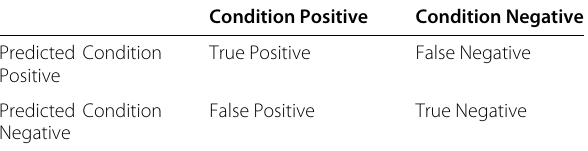
Table 3 The confusion matrix